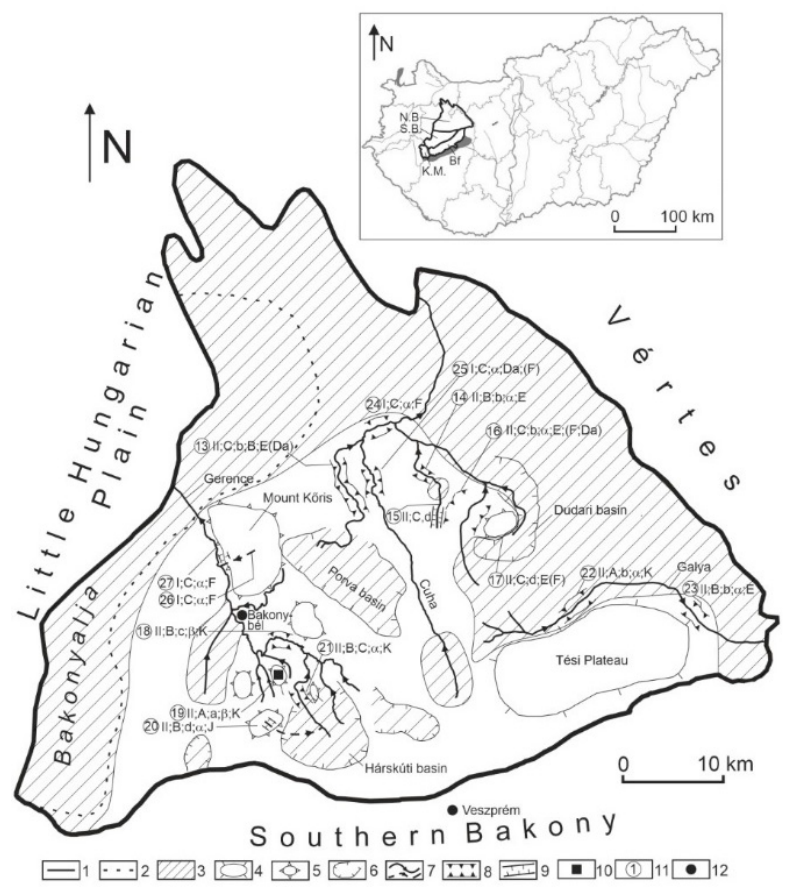
Figure 7. Karst systems in Northern Bakony that developed in the descending flows of local and regional flows. Legend: NB: Northern Bakony, SB: Southern Bakony, KM: Keszthely Mountains, Bf: Balaton Uplands, 1. Boundary of Northern Bakony, 2. Boundary of micro region group, 3. Imper- meable cover, 4. Plateau, 5. Block roof, 6. Basin, 7. Permanent and intermittent streams and their valleys, 8. Epigenetic-antecedent gorge (epigene karst system in valley), 9. Epigenetic-regression gorge, valley section with a spring (epigene karst system in valley), 10. Epigene karst system on block, 11. Identification mark of karst system, 12. Settlement, 13. K˝oris block, 14. Som block, 15. Magos block, 16. Mester-Hajag, 17. Als ó -Hajag, 18. É gett block, 19. Köz é ps˝o-Hajag, 20. T é s Plateau, 21. Porva basin, 22. Dudar basin, 23. L ó k ú t basin, 24. H á rsk ú t basin, 25. Csehb á nya basin, 26. Cuha stream, 27. H ó dos stream, A. Juvenile system, B. Adult system, C. Mature system. a. Closed epigene system, b. Mixed epigene system, c. Complex mixed epigene system, d. Incomplete system, e. Semi-closed epigene system. E. Middle Eocene limestone, K. Cretaceous limestone, J. Jurassic limestone, Da. Dachstein limestone, F. Main dolomite. α . There is phreatic opened-up cavity, β . Lack of phreatic opened up